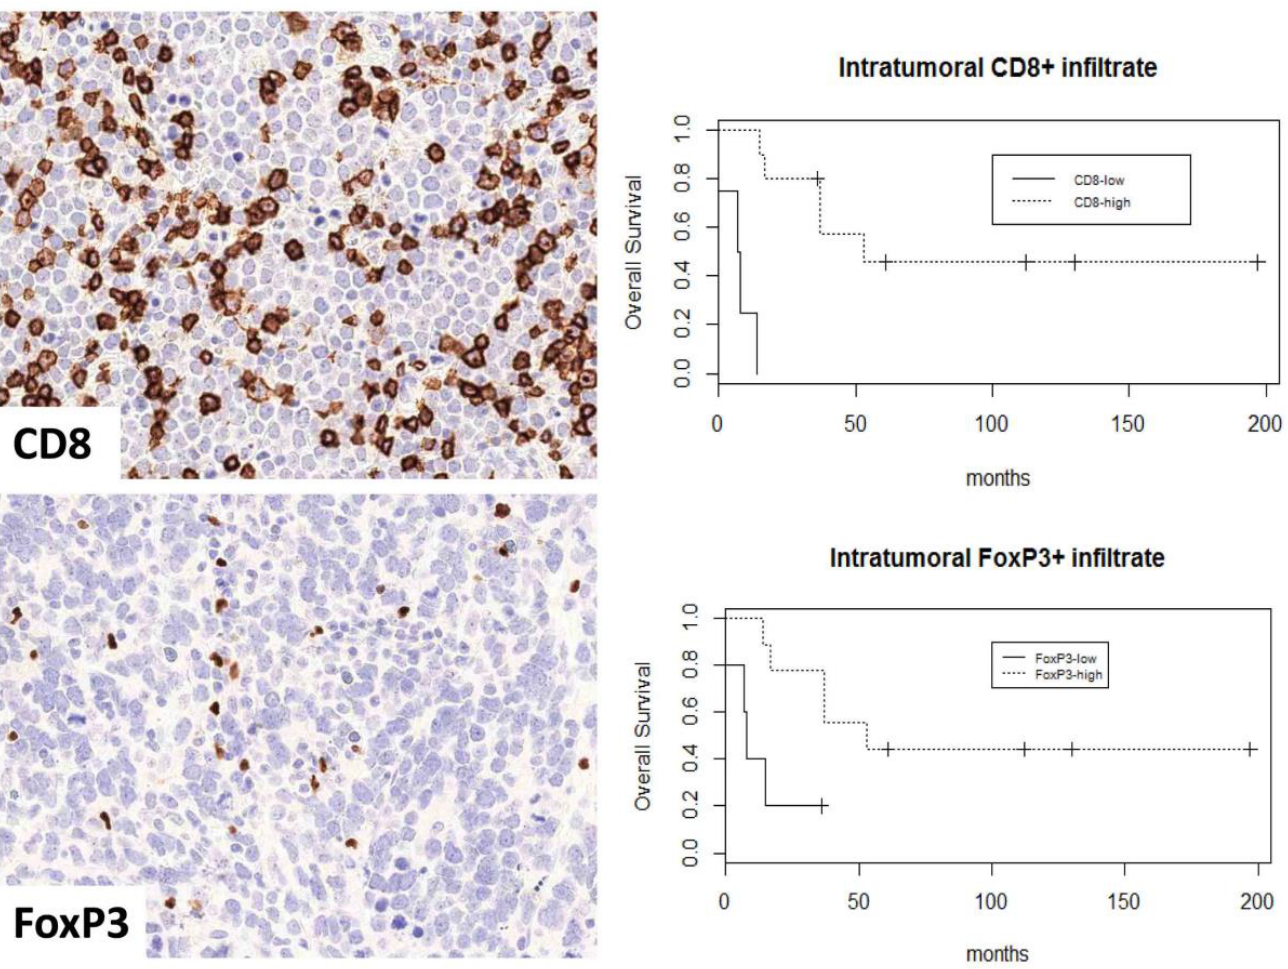
Figure 2. Kaplan–Meier curves demonstrate better overall survival in MCPyV-negative Merkel cell carcinoma of unknown primary with high intratumoral CD8+ ( p < 0.0001) infiltrate and high intratumoral FoxP3+ ( p = 0.026) infiltrate. 2.2. Virus-Positive and Virus-Negative MCC-UPs Exhibited an Immunoprofile Similar to Virus-Positive and Virus-Negative Cutaneous MCCs, Respectively The immunohistochemical expression was compared among the four groups by